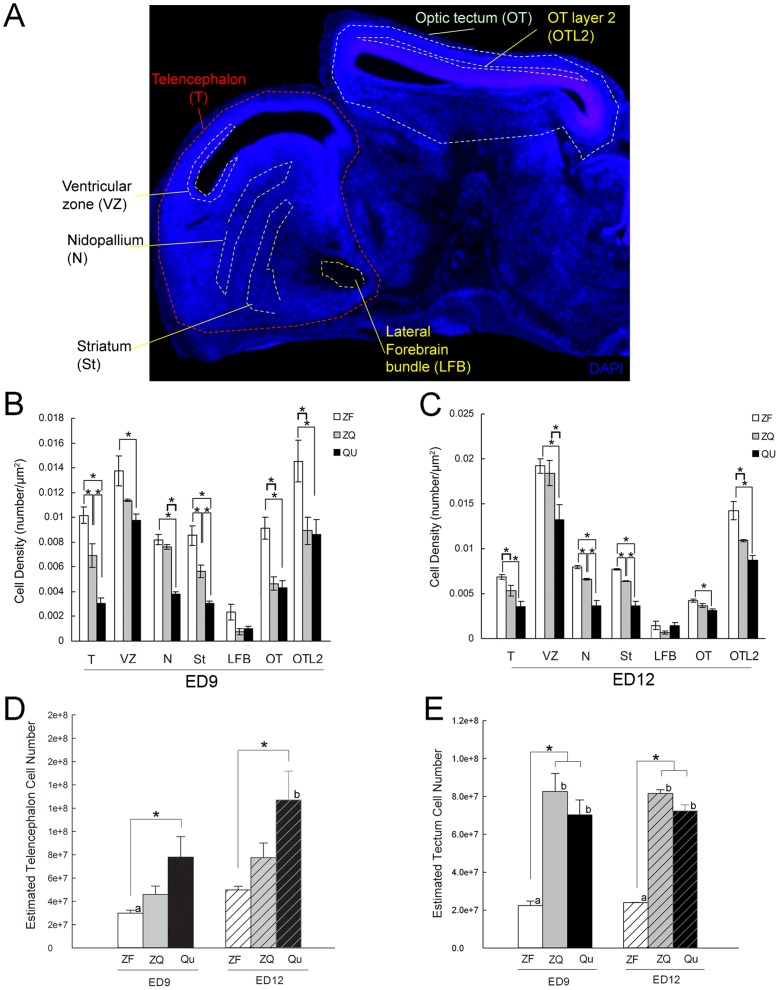
Quail host environment changes the cell density of the zebra finch telencephalon.(A) DAPI stained image of representative regions selected for cell density measurements in a quail sagittal sections at ED12. (B) Estimated cell density in subregions at ED9. (C) Estimated cell density in subregions at ED12. (D) Estimated total cell numbers in the telencephala at ED9 and ED12. (E) Estimated total cell numbers in the tecta. *: p<0.04, among groups; a–b: p<0.04 between stages; Kruskal–Wallis one-way ANOVA, Dunn's post hoc test in VZ in (B), St in (C), and in (D); parametric one-way ANOVA, Tukey's post hoc test in rest of regions in B, C and E (at ED9, n = 4 ZF, 4 ZQ, and 3 QU; at ED12, n = 3 ZF, 3 ZQ, and 3 QU). Error bars, S.E.M.